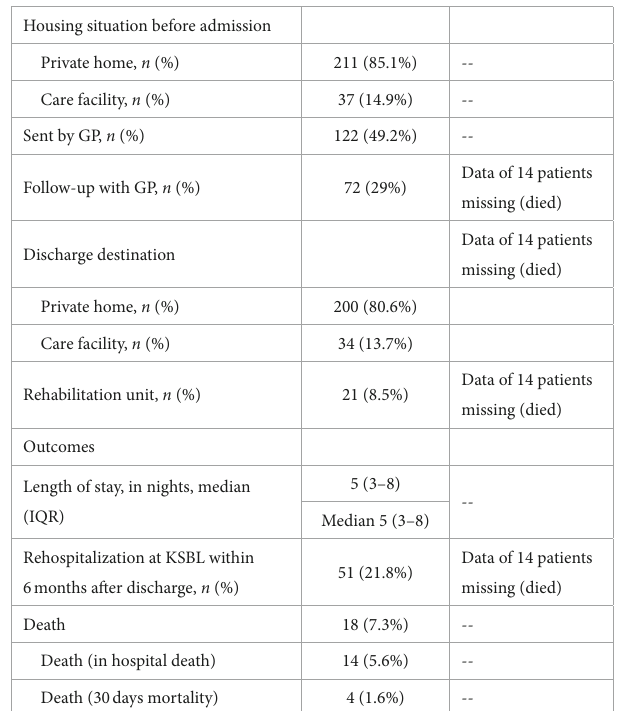
TABLE 1 Patient